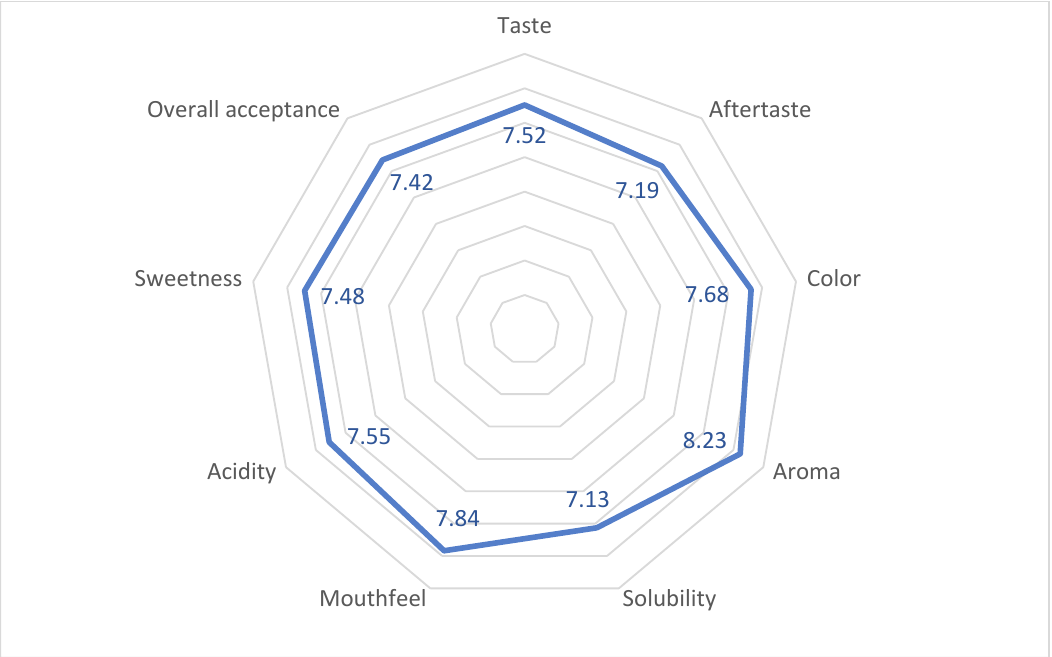
Figure 5. Sensory profile of the sports beverage. Table 4. Questionnaire results.